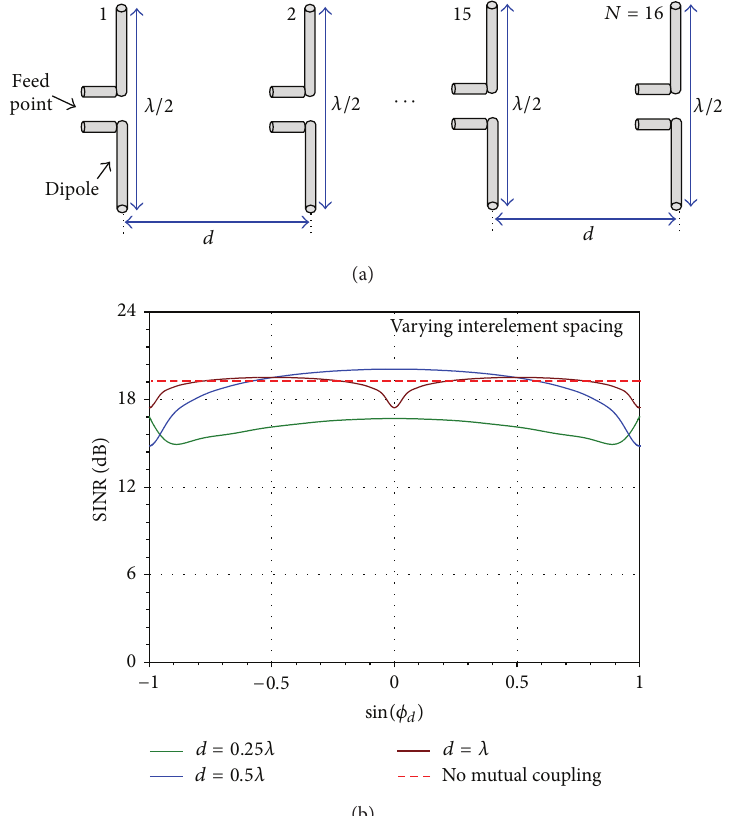
Figure 5: Effect of inter-element spacing on output SINR of a 16-element array of half-wavelength, center-fed dipoles; 𝜉 𝑑 = 10 dB, 𝜃 𝑑 = 90 ∘ . (a) Schematic of dipole array (b) Output